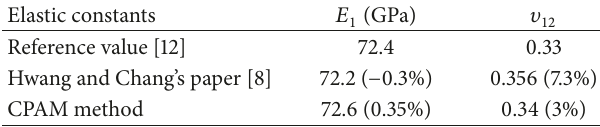
Table 7: Two determined elastic constants for the aluminum